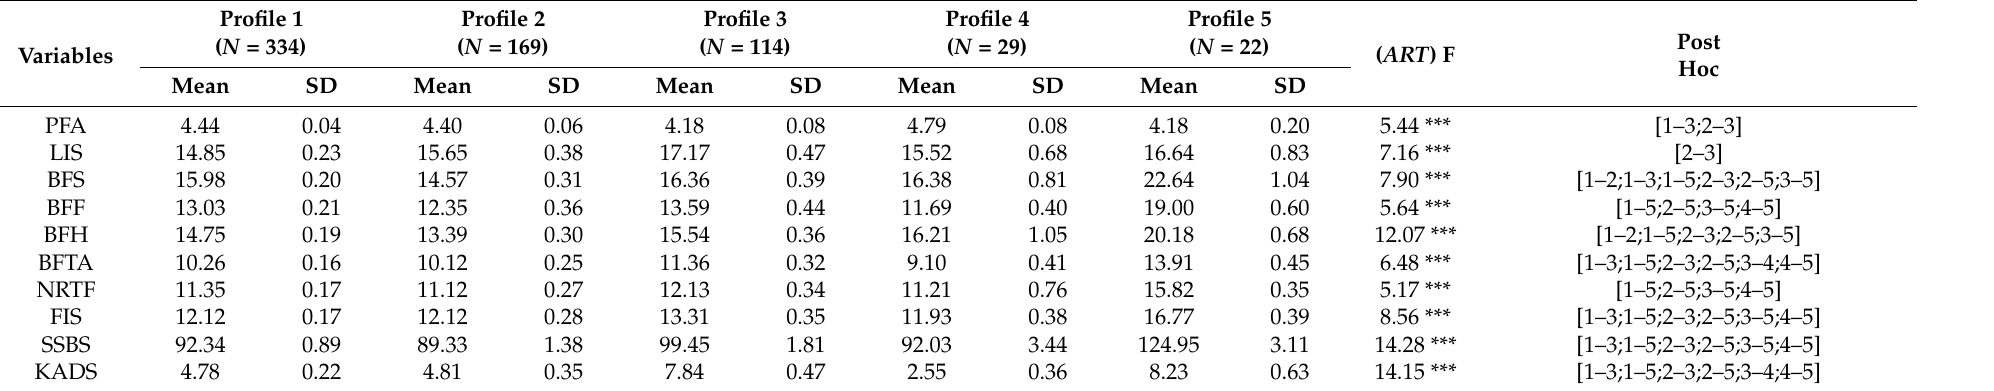
Table 3. Means and standard errors for the five profiles identified through LPA, for perceived family acceptance, school burnout, and depression ( N =